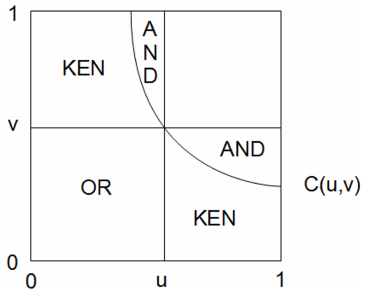
Fig. 2. Graphical representation of the different JRP definitions in terms of a copula (2-D